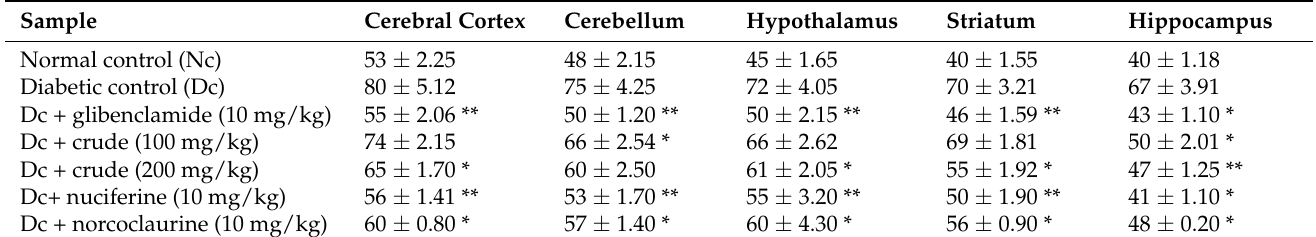
Table 4. Effect of N. nucifera crude, nuciferine and norcoclaurine on AChE activity in various brain regions of diabetic rats ( µ mol AcSCh/h/mg of protein).